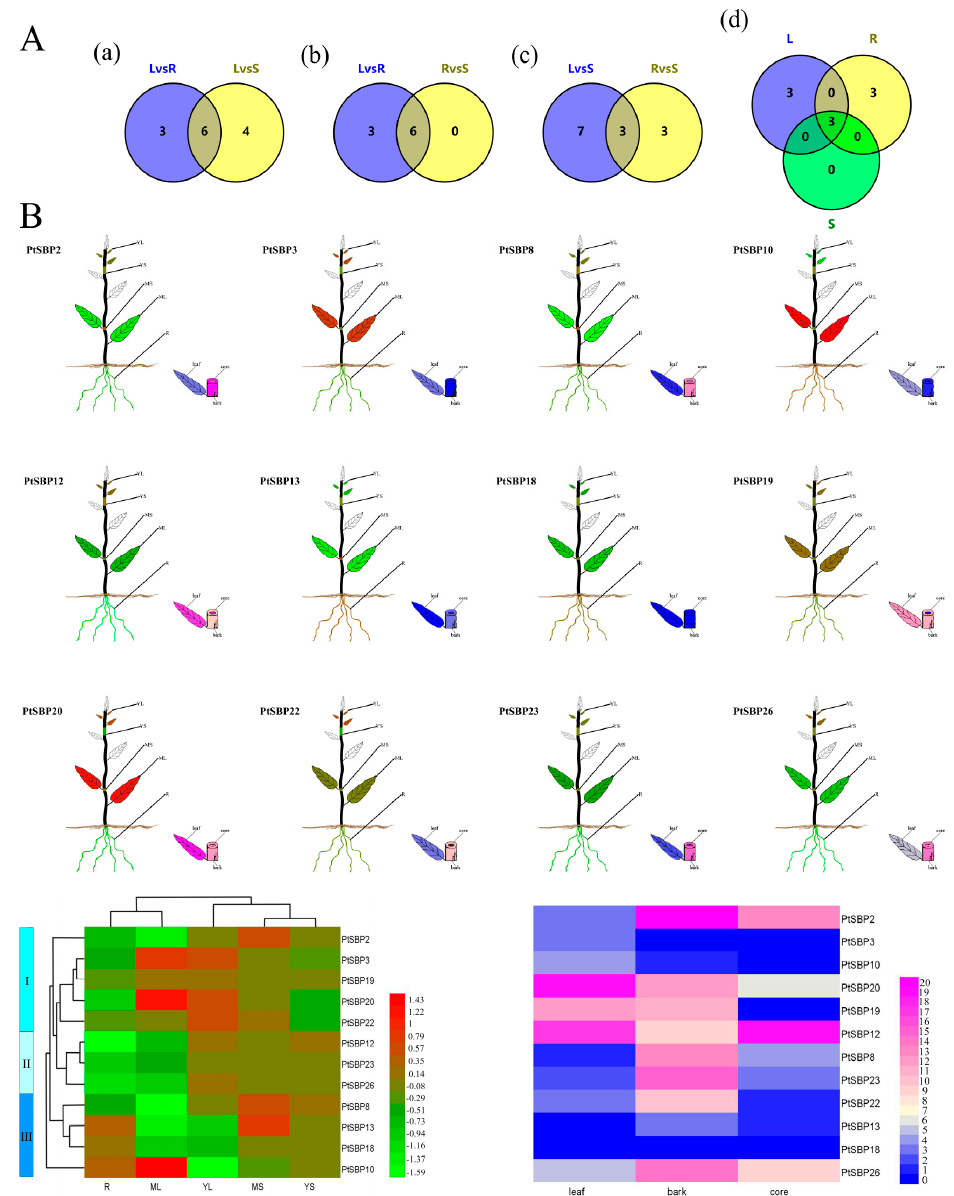
Figure 8. ( A ) Veen diagram for tissue specific analysis of PtSBP . The figure ( a – d ) show the number of DEGS in different tissues and the shared genes. R: Root, S: Stem, L: leaf. ( B ) The expression of different PtSBP in different tissues. R: Root, MS: Mature stems, YS: Young Stems, YL: Young Leaves, ML: Mature Leaves. The expression level is visualized by TBtools. Red and pink represent high expression levels, and green and blue represent